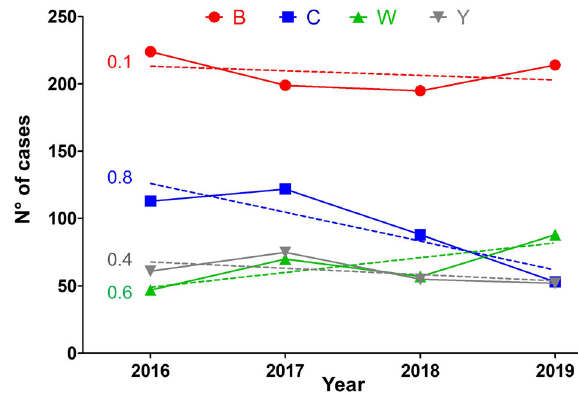
Fig. 1 Evolution of number of cases of IMD per serogroup during the period 2016 – 2019. The four serogroups (B, C, W and Y) are represented by a different colour with the number of cases indicated per year. The dashed lines represent the linear regression for the corresponding serogroup with the r 2 value indicated with the same colour as the corresponding